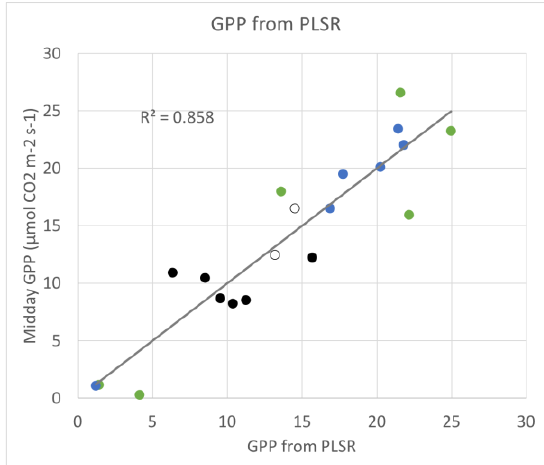
Figure 10 . PLSR using DESIS reflectances compared with midday GPP. Point colors are described in Fig. 3